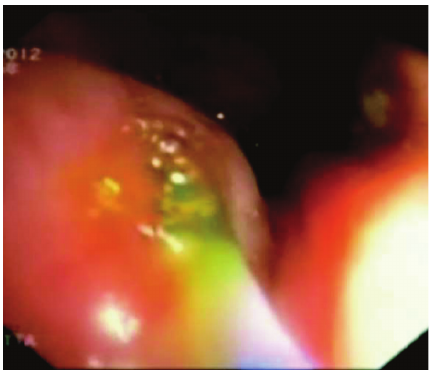
Figure 4: Appendiceal orifice irrigated using a catheter and pus